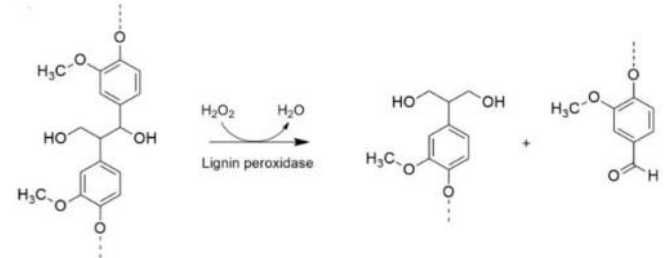
Figure 2. Reaction catalyzed by LiP of cleavage C-C [10].